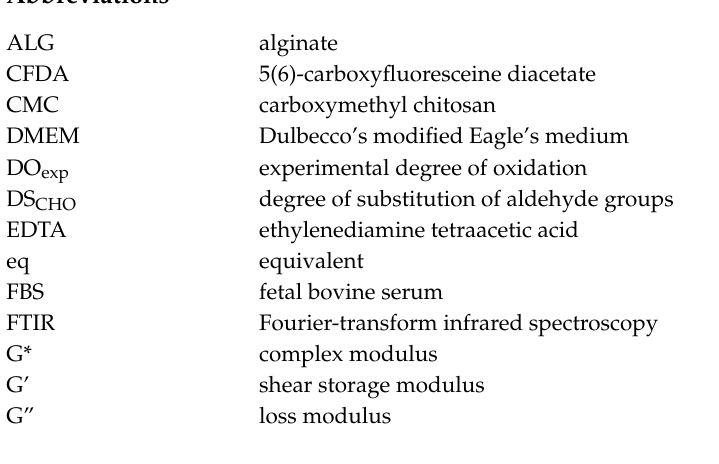
Figure S1: The integral titration curve of amino groups in CMC; Figure S2: Correlation studies between the CHO content of oALG and the metabolic activity of 3T3- L1 fibroblasts; Figure S3: Correlation studies between the CHO content of oHA and the metabolic activity of 3T3-L1 fibroblasts; Table S1: E ff ect of Polysaccharides Oxidation on Weight Average Molecular Weight (Mw) and Polydispersity Index (PDI) of Alginate (ALG); Table S2: E ff ect of Polysaccharides Oxidation on Weight Average Molecular Weight (Mw) and Polydispersity Index (PDI) of Hyaluronic acid